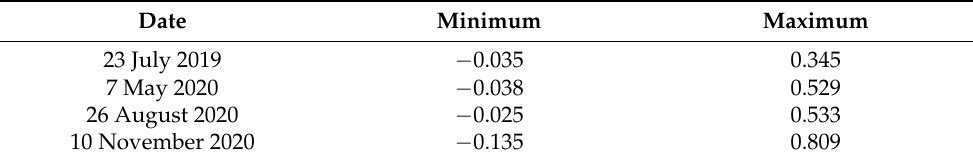
Table 3. NDVI maximum and minimum